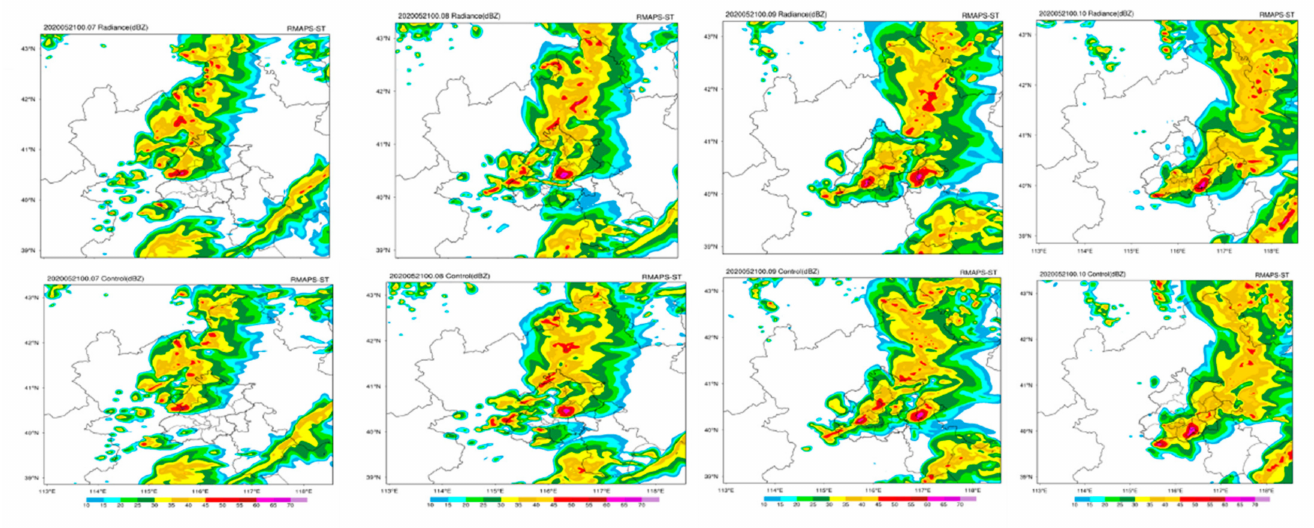
Figure 5. Composite reflectivity during the period from 0700 UTC to 1000 UTC on 21 May 2020 simulated by MWRPS test and control test from top to bottom (Beijing-Tianjin-Hebei region shown).